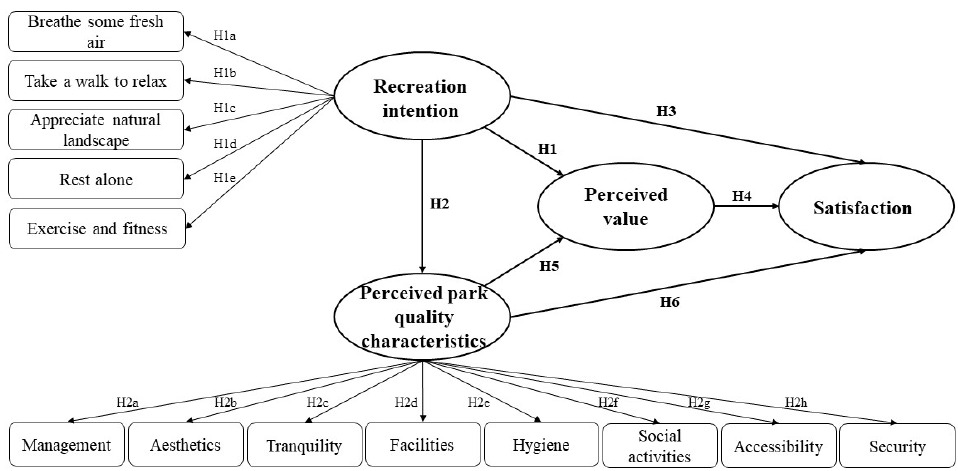
Figure 3. Conceptual model of recreation satisfaction of blue-collar workers.